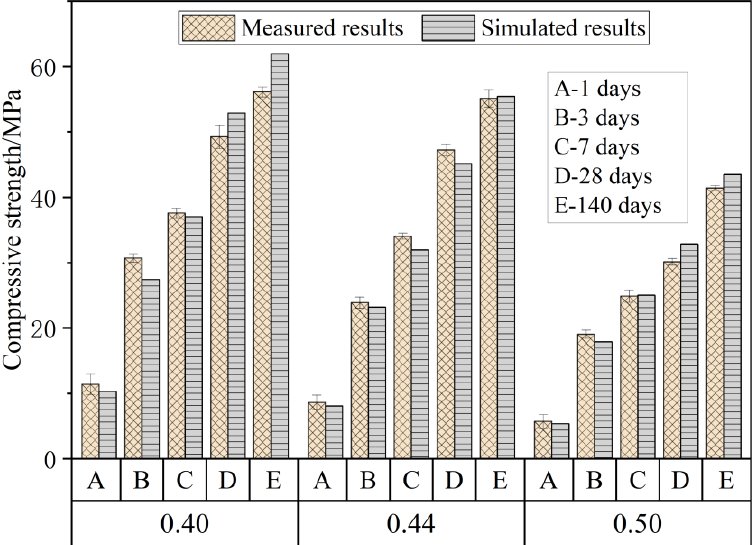
Figure 6. Measured and simulated compressive strength of cement stone.